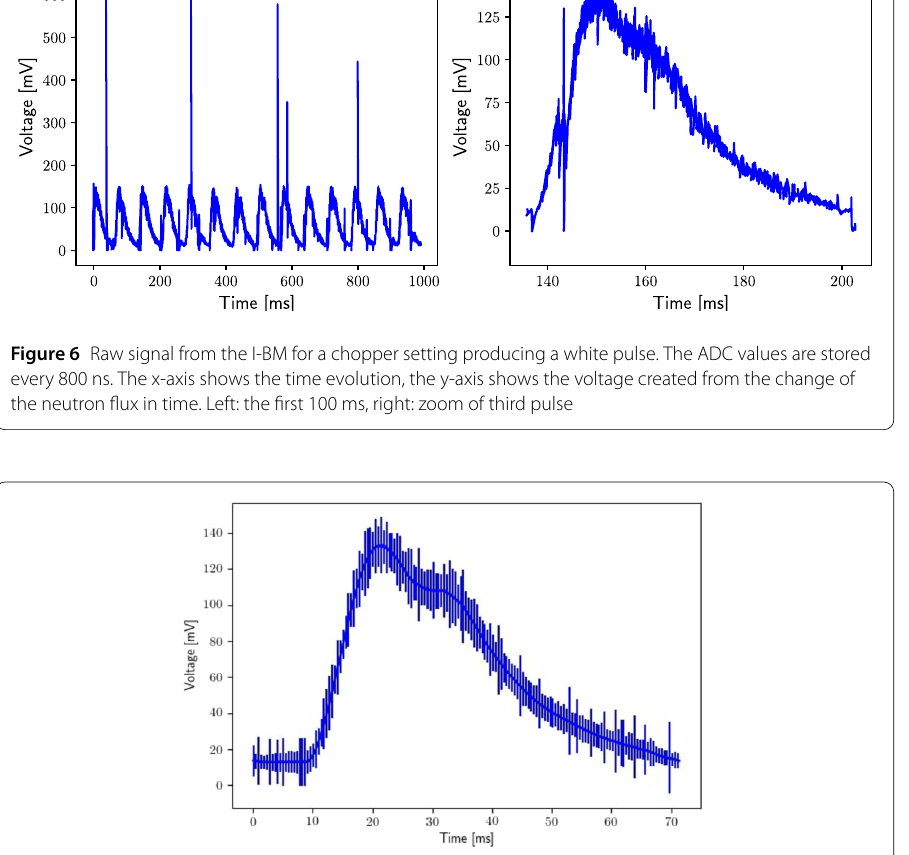
Figure 7 Pulse characteristics of the highest flux achieved at V20 with the white pulse setting. The main pulse is averaged over ca. 40000 pulses and the error bars represent the average Gaussian spread of